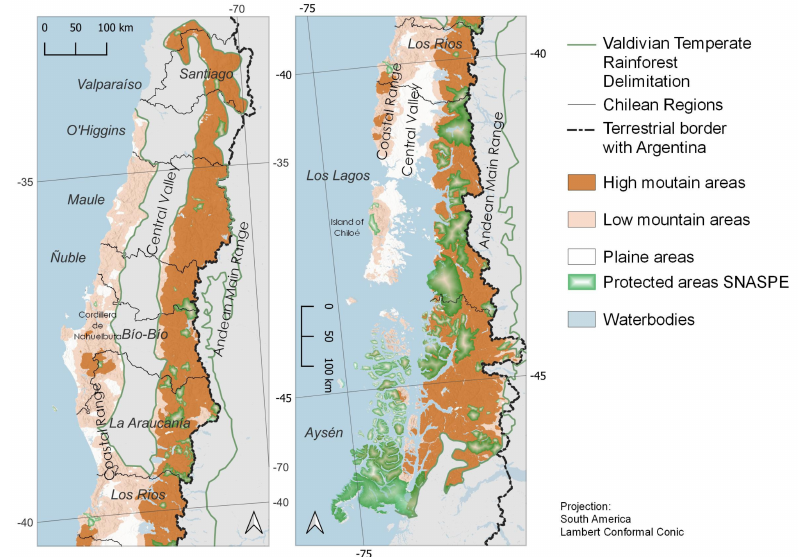
Figure 3. Distribution of mountains, administrative delimitations and public protected areas within the Chilean part of the Valdivian temperate rainforest Source: Own illustration out of databases mentioned in methodology part and Elevation Hillshade (Map Server)